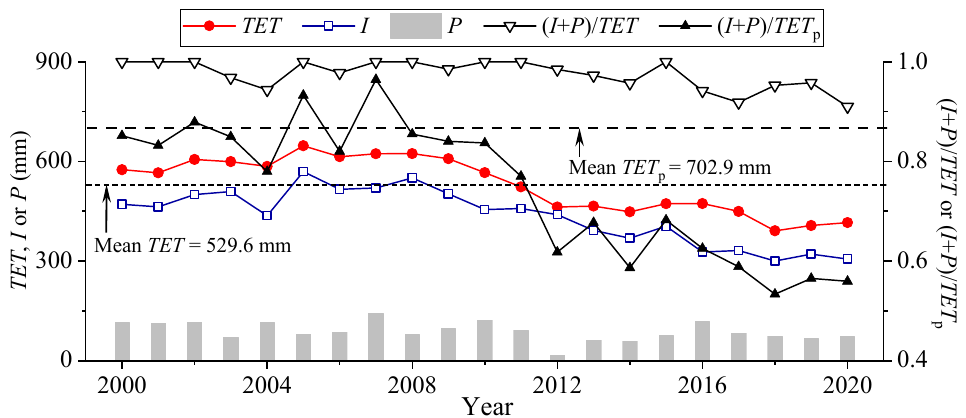
Figure 10. Actual evapotranspiration ( TET ), irrigation amount ( I ), effective precipitation ( P ), ratio of water supply to evapotranspiration (( I + P )/ TET ) and relative water supply (( I + P )/ TET p ), mean of actual evapotranspiration (Mean TET ), and mean of potential evapotranspiration (Mean TET p ) for cotton fields under film-mulched drip irrigation in the Manas River Basin from 2000 to 2020.